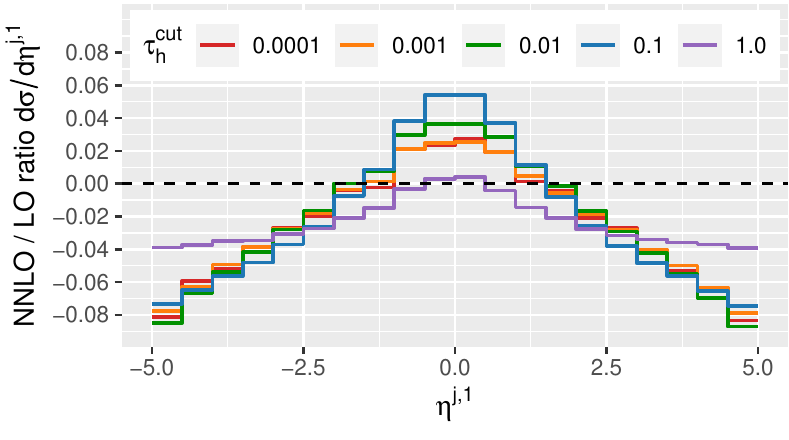
Figure 5 . NNLO corrections from the heavy-line production vertex for the leading jet pseudo- rapidity distribution, relative to LO . The (automatically) fitted result coincides within numerical uncertainties with the τ cut = 10 − 3 h